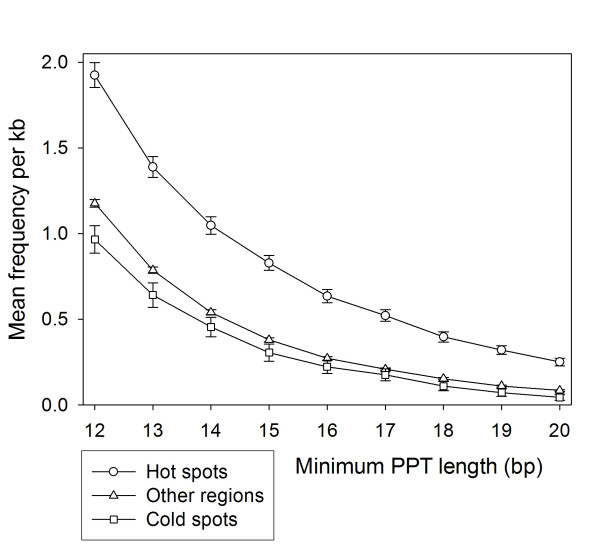
Association of high PPT frequencies with yeast hot spots. Mean frequencies of PPTs with length minima between 12 and 20 bp in 177 hot spots of meiotic double-strand breaks (DSBs) in the genome of the yeast S. cerevisiae compared with the mean frequencies in 40 DSB cold spots and 233 other regions comprising the remainder of the genome sequence. Error bars are plus and minus one standard error of the mean.